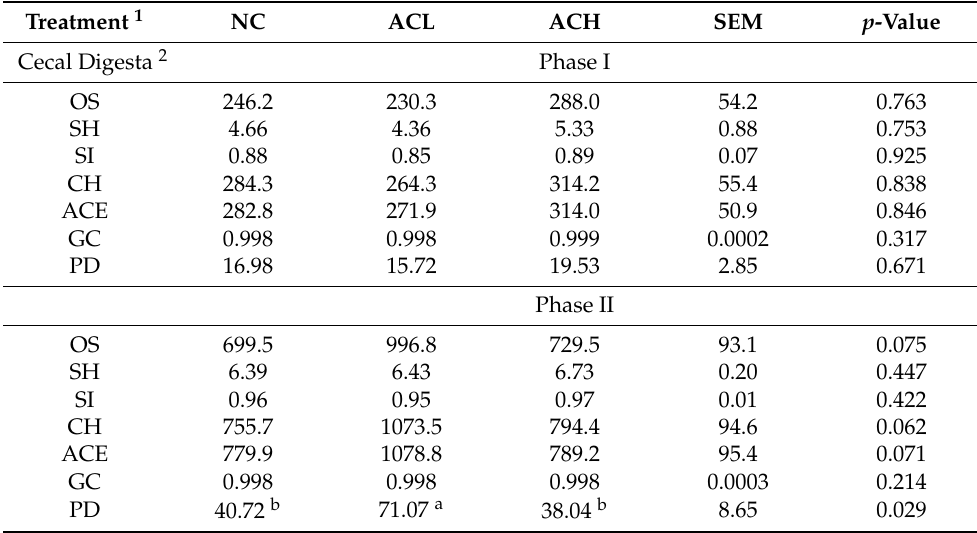
Table 10. Effect of different levels of aging corn on alpha ( α ) diversity in cecal chyme of broilers. Treatment